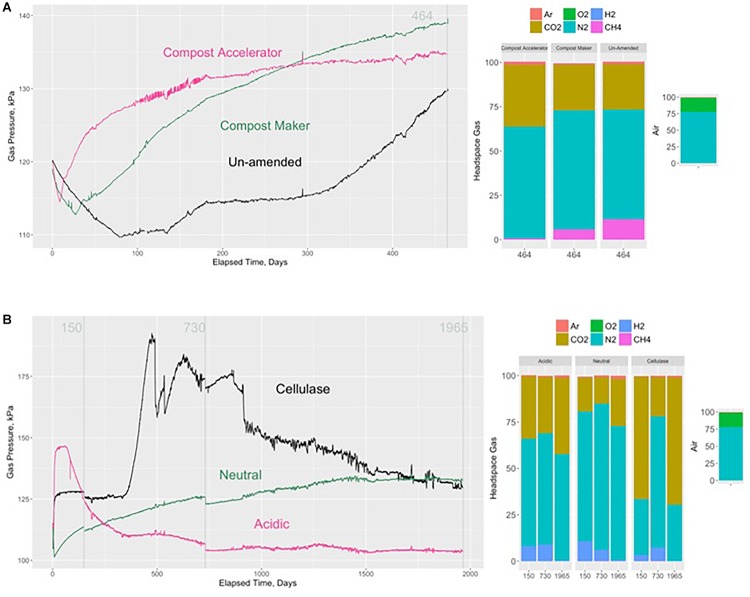
Evolution of gas pressure and headspace gas compositions without adding compost (control) and after adding Compost Accelerator and Compost Maker over 464 days (A). Numbers in gray correspond to the vertical gray lines marking when the headspace gases were sampled for analysis at 464 days elapsed time. Evolution of gas pressure and headspace gas compositions after adding a citrate buffer (acidic), a phosphate buffer (neutral), and cellulase over 1965 days (B). Numbers in gray correspond to the vertical gray lines marking when the headspace gases were sampled for analysis at 150, 464, 730, and 1965 days elapsed time. Also shown are the composition of the nitrogen, oxygen, argon, carbon dioxide, hydrogen, and methane in the headspaces and in dry air.